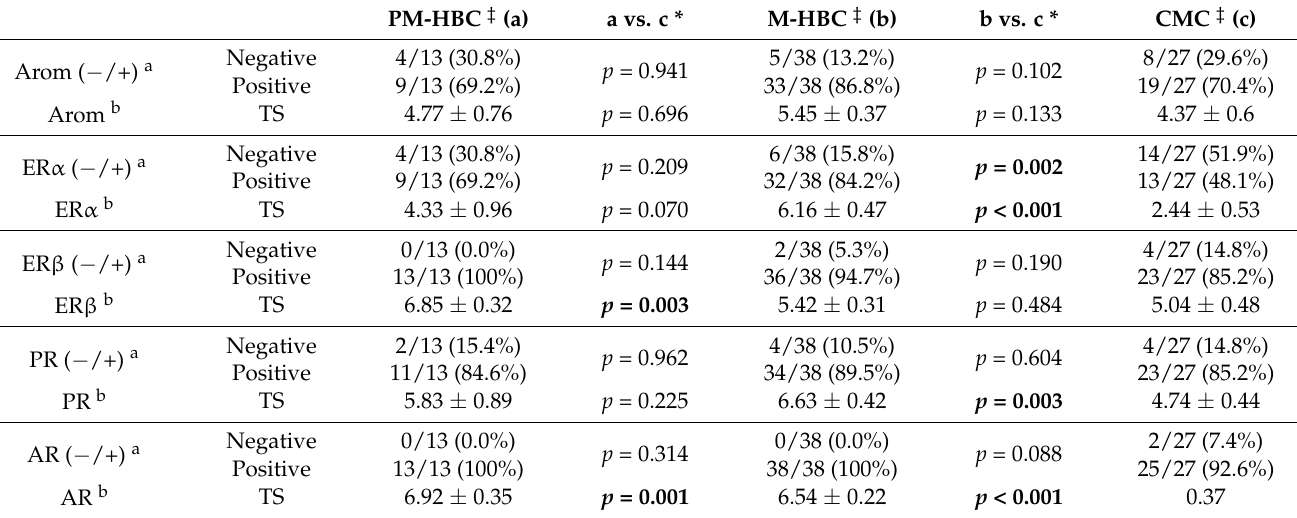
Table 3. Immunoexpression of aromatase and steroid receptors in human breast cancer and canine mammary cancer samples.